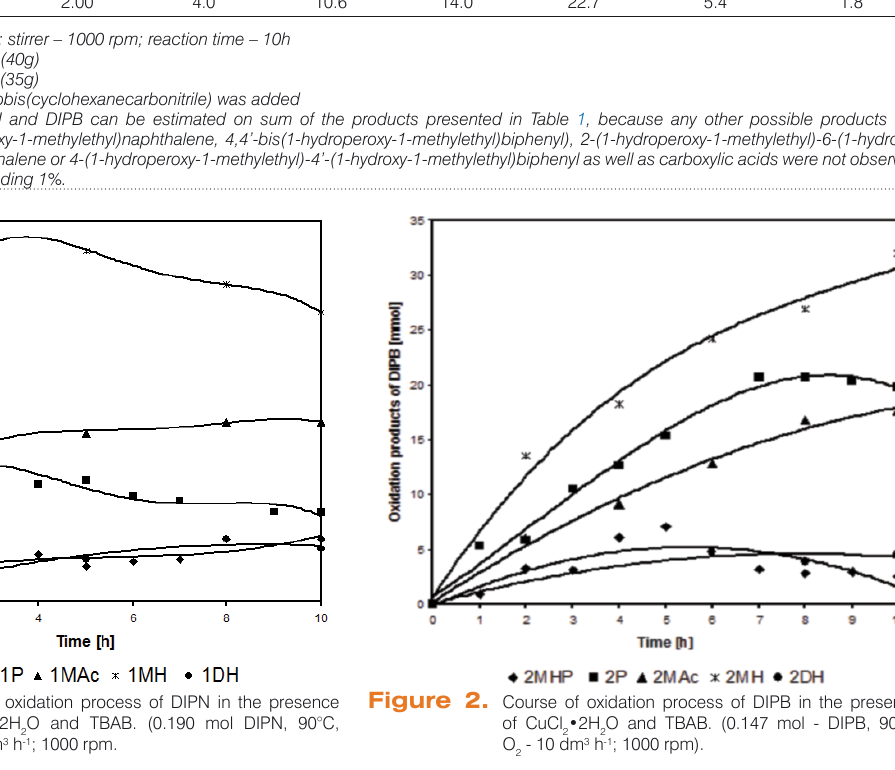
Oxygen - 10 dm 3 h -1 ; stirrer – 1000 rpm; reaction time – 10h a DIPN – 0.190 mol (40g)